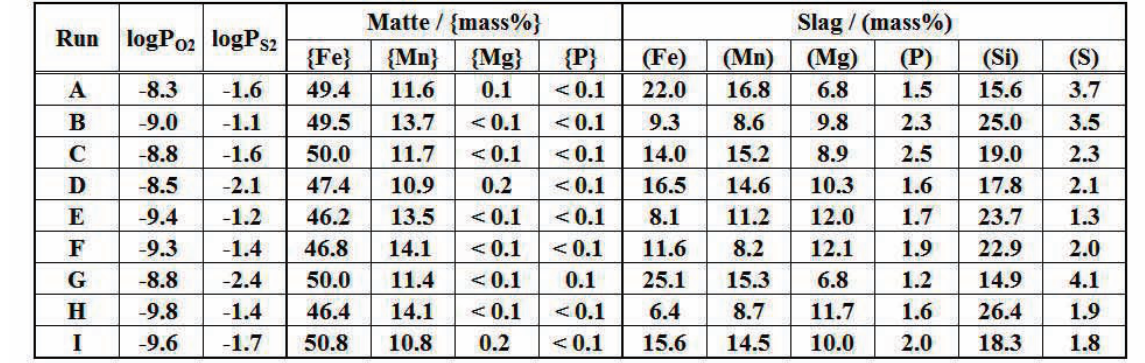
Table 4. Experimental results for series 2.